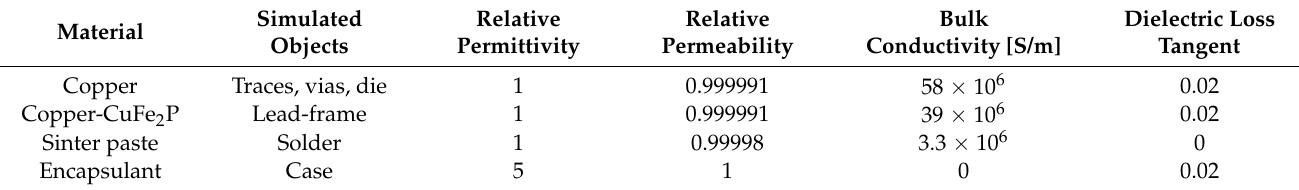
Table 1. Material properties used for electromagnetic